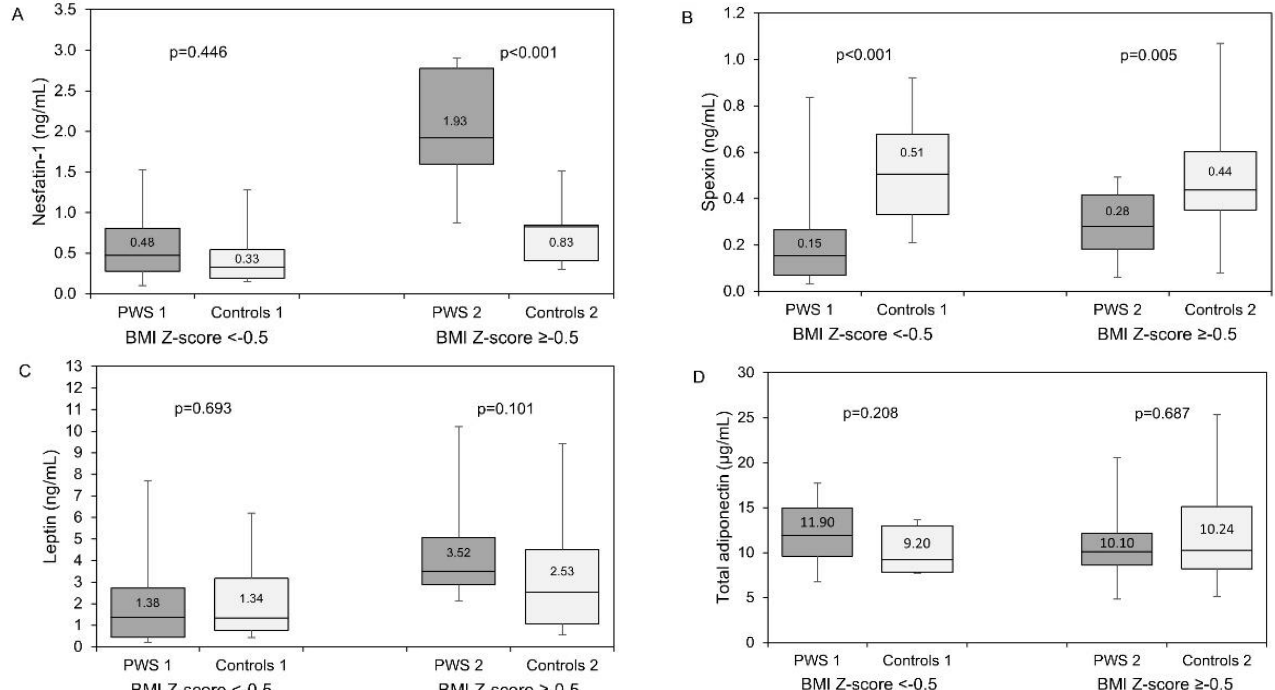
Figure 1. Comparison of nesfatin-1 ( A ), spexin ( B ), leptin ( C ), adiponectin and ( D ), concentrations between groups with PWS and the appropriate control groups. Patients with PWS (dark boxes), Control groups (bright boxes); BMI—body mass index.